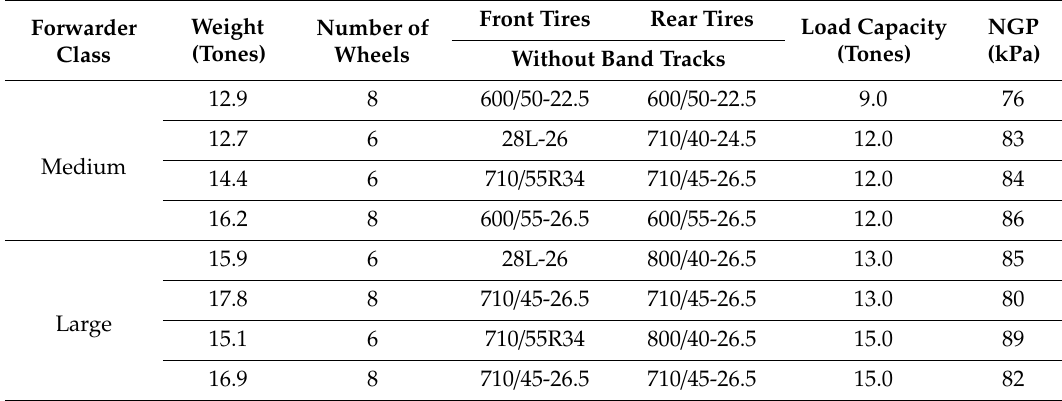
Table 3. Nominal ground pressure (NGP) of selected forwarders. Based on